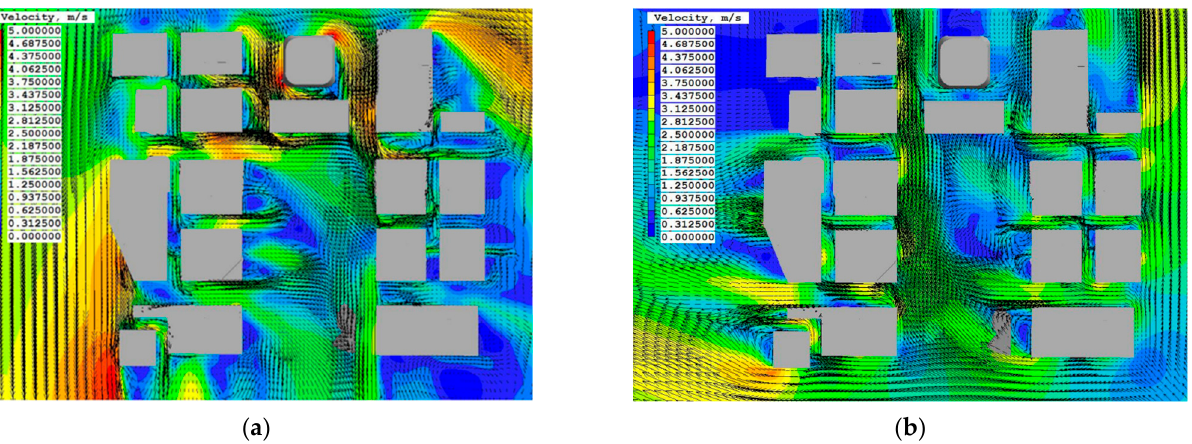
Figure 13. Air velocity distribution of the CFD simulation (plane view above-ground at 20 m). ( a ) winter; ( b ) summer.